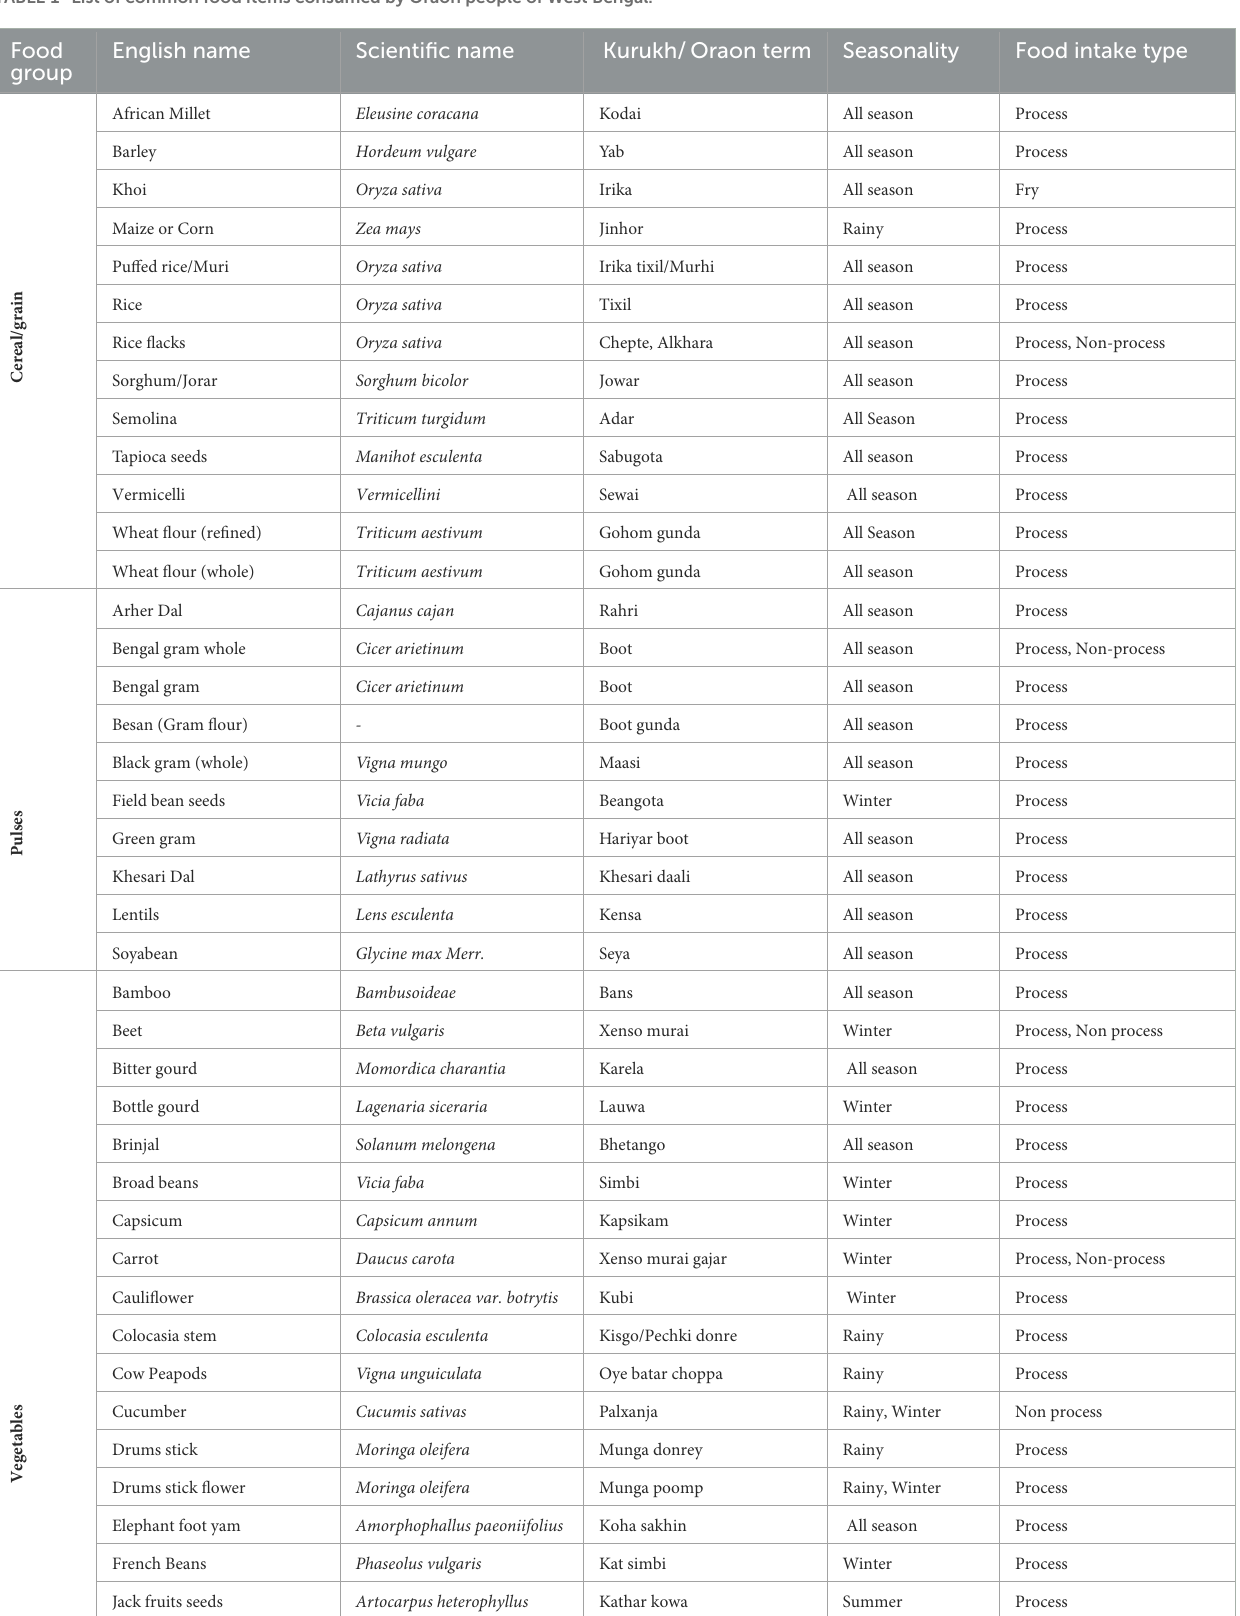
TABLE 1 List of common food items consumed by Oraon people of West Bengal. Food